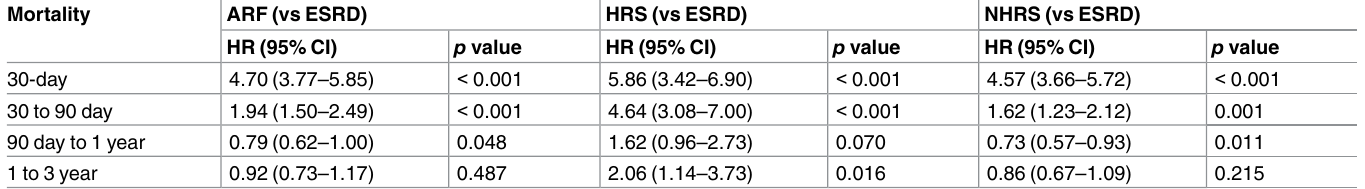
Table 4. Adjustedhazard ratiosof acuterenal failurefor the 30-day, 30 to 90-day, 90-day to 1-year, and 1 to 3-year mortality of cirrhotic patients, comparedto the end stagerenal diseasegroup.